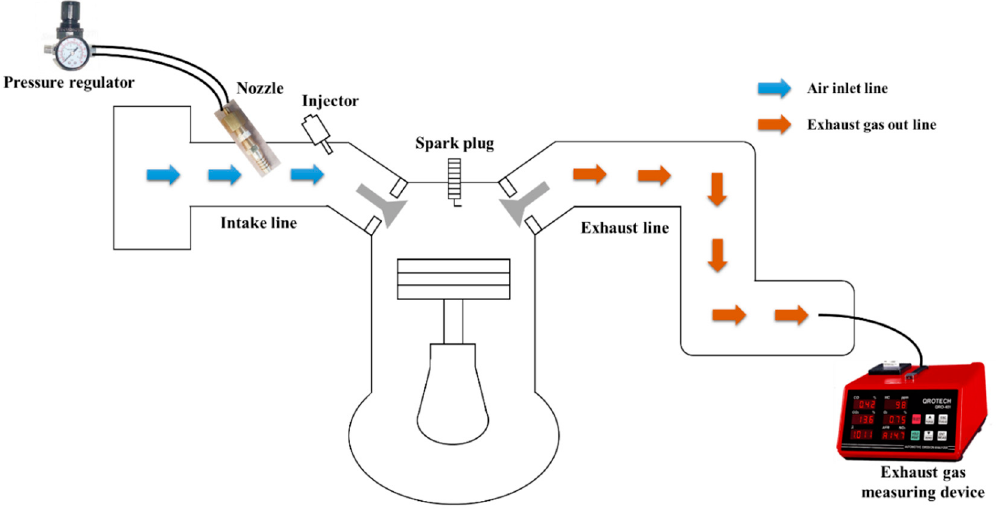
Figure 4. Schematic of the experimental setup. Table 5. Experimental conditions.